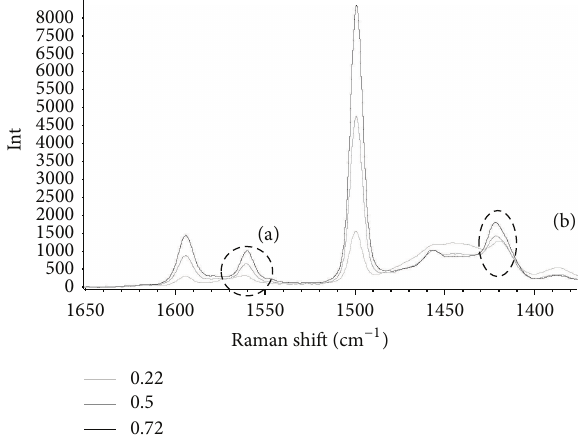
Figure 3: Raman spectra of {𝑥 BT + (1 − 𝑥) [ BMIM ][ OSO 4 ]} over the range of 1600–1400cm −1 with the mole fraction increasing from 0.22 to